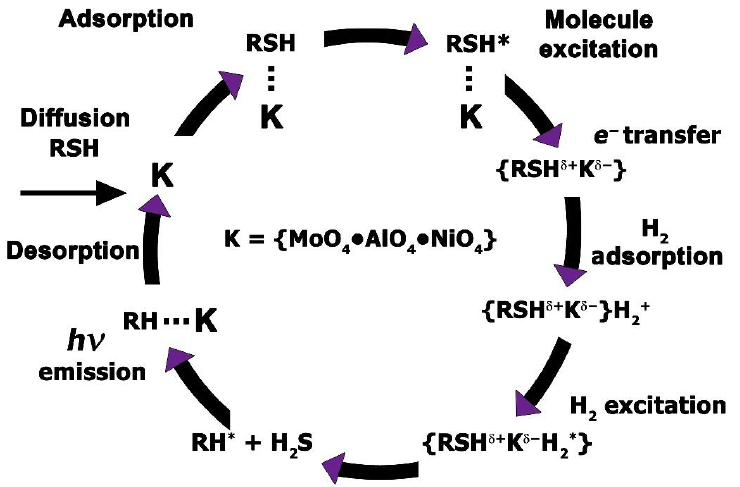
Figure 6. Scheme of the mechanism of catalytic hydrodesulfurization of mercaptan molecules (RSH + H2) in the presence of an ensemble of tetrahedra {MoO 4 ·AlO 4 ·NiO 4 }. The orbital cycle of the stages of the process of hydrodesulfurization of mercaptane RSH molecules in the presence of an ensemble of tetrahedra is presented below {MoO 4 ∙AlO 4 ∙NiO 4 } with the possible replacement of so me of the oxygen ions by S 2− . The mechanism of the catalytic hydrodesulfurization of diesel fuel can be repre- sented based on the Generalized quantum chemical principle formulated in [26 – 28] as a sequence of the following stages: I stage. The RSH molecule is diffused from the volume of the reaction mixture to the active ensemble of the tetrahedra K, and under the influence of the electromagnetic field of ions Mo n+ , Al m+ , and Ni z+ with the symmetry B , an electron on the molecular orbital (MO) of the mercaptan molecule with the symmetry of the irreducible representation of the B interacts with the vacant atomic orbital (AO) nd 0 of the catalyst active center. The interaction of the active center K and the molecule of mercaptan ensures the ap- pearance of a full-symmetric representation of A: B· B = A. Such interaction is allowed from the point of view of group theory, since the symmetry of the valence 𝜋 𝑃 𝑧 𝑃 𝑧 2 MO of mercaptan coincides with the nd 0 -AO symmetry of the active tetrahedron (zero-vacant AO). A favorable orientation of the flat mercaptan molecule in the electromagnetic field of the tetrahedron with the highest acceptor strength [MoO4] 2 − occurs. The mercaptan mol- ecule can be oriented vertically or horizontally to the surface of the catalyst. II stage. The molecule RSH is adsorbed on the active center of the tetrahedron ensem- ble as a result of the Van der Waals interaction when the mercaptan molecule approaches the catalyst surface. The adsorbing mercaptan molecule contains a pair of free electrons on the sulfur atom and exhibits an increased donor capacity for the [MoO 4 ] tetrahedron, which has an increased acceptor force, stabilized by the [AlO 4 ] and [NiO 4 ] tetrahedra. In addition, the tetrahedra [MoO 4 ] and [AlO 4 ] have an electromagnetic field sufficient to at- tract a mercaptan molecule (another sulfur-containing compound or unsaturated hydro- carbon) at a distance of 0.8 − 1 Å . The orientation of RSH molecules on an ensemble of tetrahedra (horizontally or vertically) with its orientation in the field of two tetrahedra is favorable for the excitation of a pair of electrons on the C-S bond. As was shown above, the adsorption of a mercaptan molecule on active centers in the ground (non-excited) state is also permitted from the position of group theory, since the product of irreducible representations of the vacant atomic orbital of the molybdenum